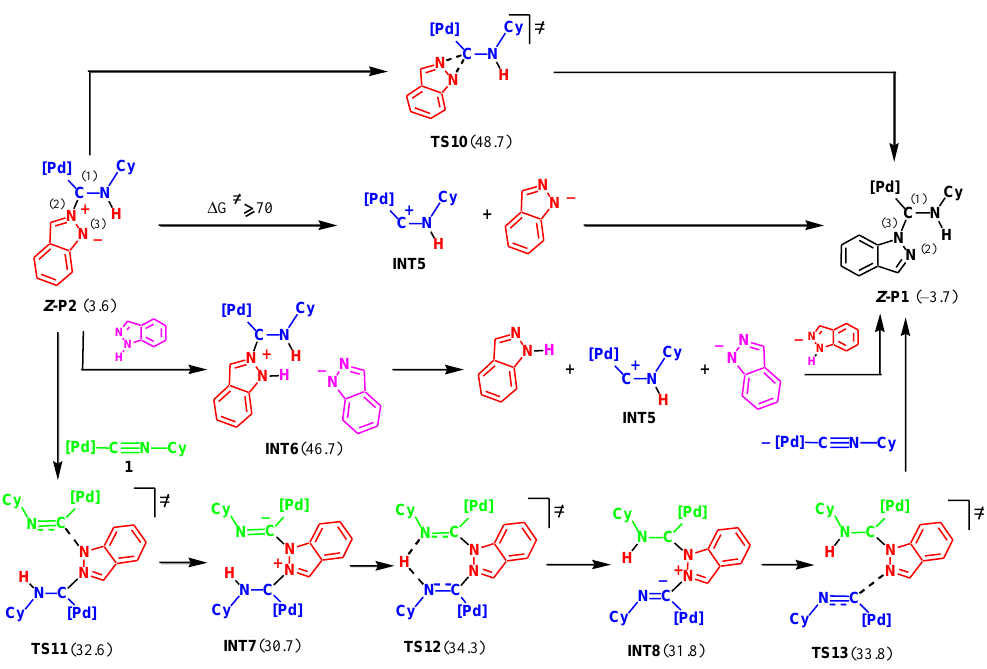
Scheme 7. Possible mechanisms of isomerization of P2 into P1 (Gibbs free energies relative to 1 + Ind are shown in kcal/mol).